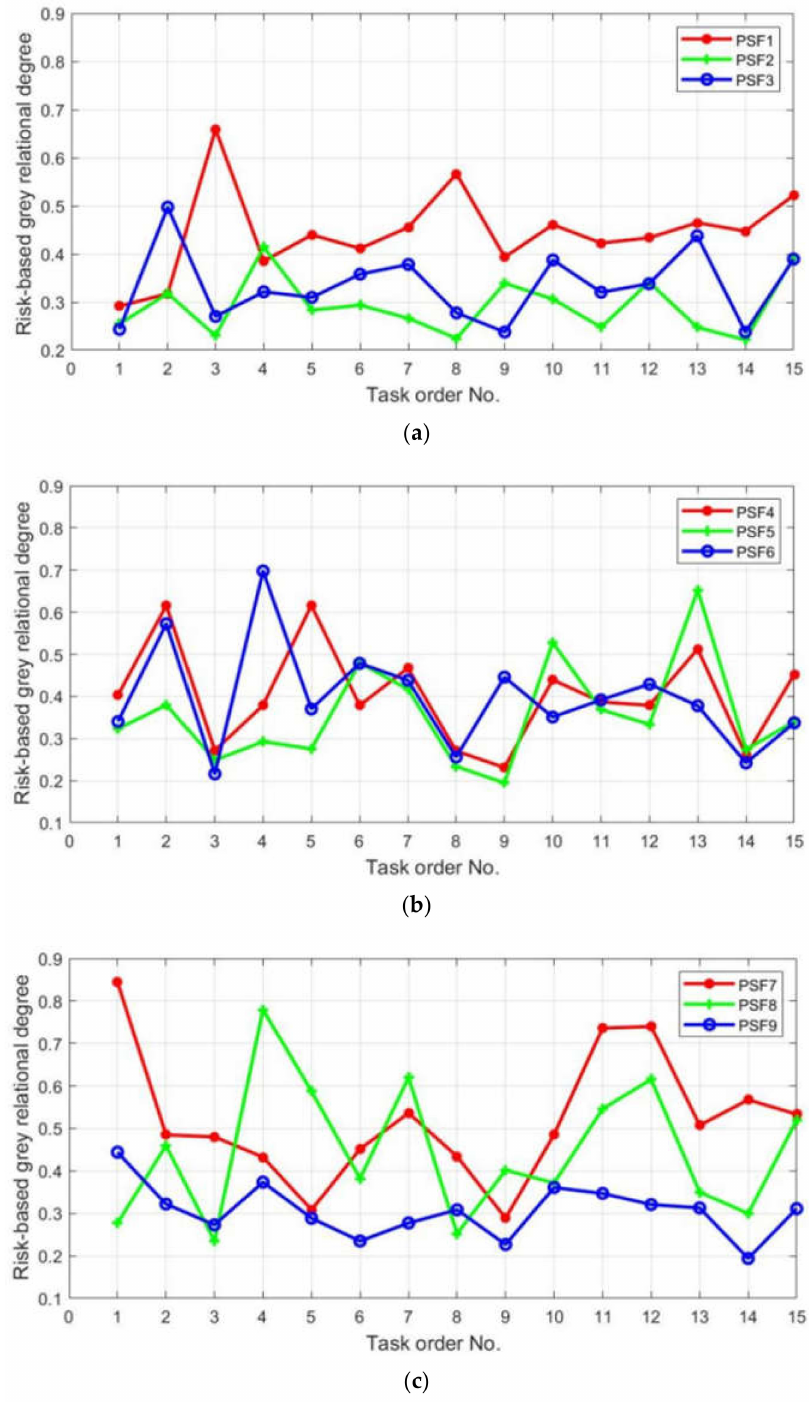
Figure 8. Risk-based grey relational degrees in each ST: ( a ) PSF1, PSF2, PSF3; ( b ) PSF4, PSF5, PSF6; ( c ) PSF7, PSF8,